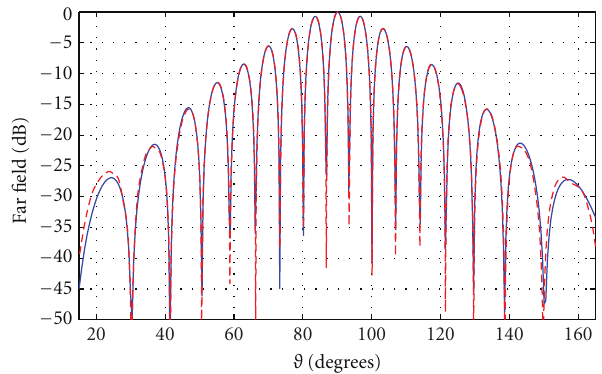
Figure 15: Dual horn, horizontal polarization, sum pattern. ϑ cut of the ϕ component of the far field. Blue solid line: proposed approach. Red dashed line: approach in [7, 8].